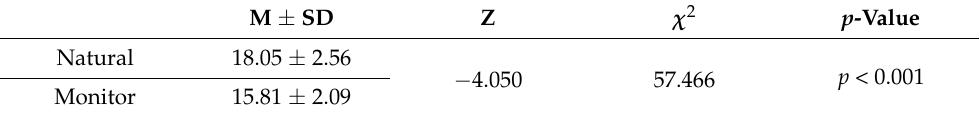
Table 1. Comparison of the blink rate in the natural environment and monitor environment ( n =